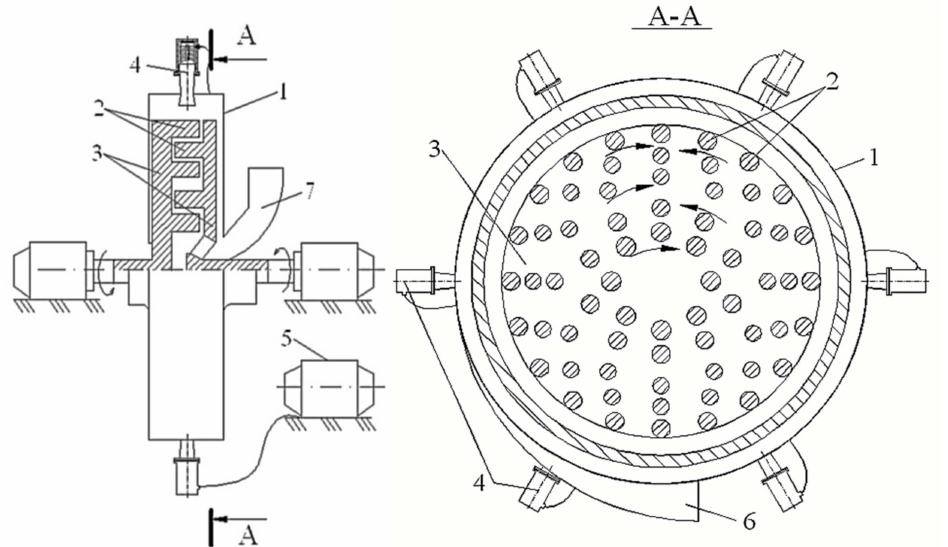
Figure 1. Activation installation (disintegrator). 1—cap; 2—fingers; 3—discs; 4—nozzles; 5—pump; 6—drain; 7—feed funnel. (A-A—cross